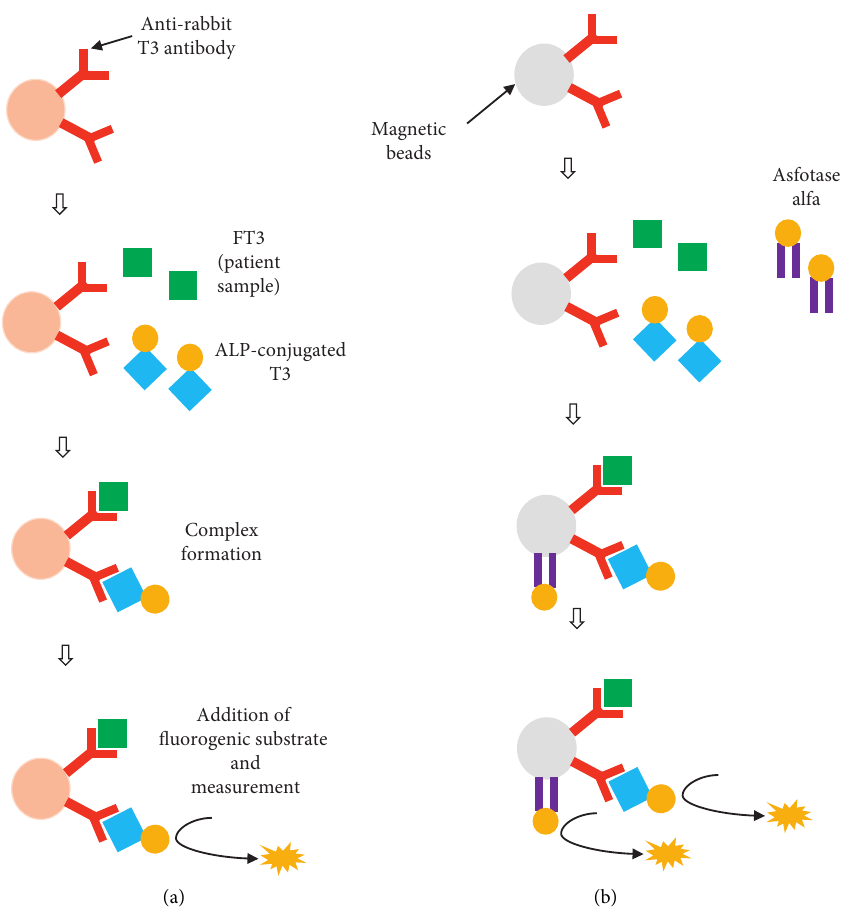
Figure 1: Schematic images of how asfotase alfa interferes with the measurement of thyroid hormone (FT3) levels in AIA-2000. (a) Normal methods used to assess FT3 levels, including AIA-CL2400. (b) Possible interference mechanism in the AIA-2000 system. Asfotase alfa inappropriately binds to magnetic beads, leading to spurious thyroid function